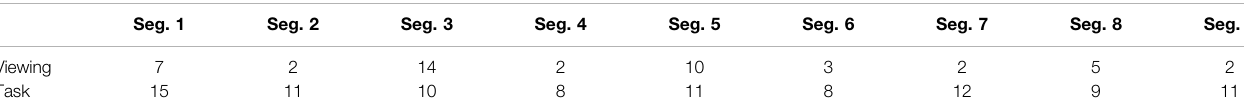
TABLE 2 | Number of participants excluded out of 70 for DFA α 1 analysis.